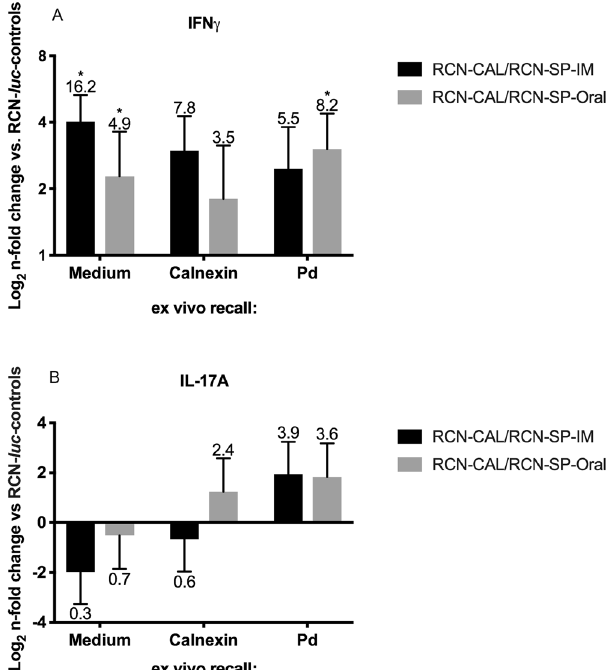
Figure 6. Expression of IFN- γ ( A ) and IL-17A ( B ), measured by RT-PCR, in pooled spleen and axillary lymph nodes of vaccinated Myotis lucifugus after challenge with Pseudogymnoascus destructans (Pd) , and ex vivo recall with calnexin (CAL), Pd or medium (non-stimulated). Bats had been vaccinated with raccoon poxviruses (RCN) expressing CAL and serine protease (RCN-CAL/RCN-SP) via intramuscular (IM; n = 8) or oral (n = 7) administration, or sham vaccinated with RCN expressing luciferase (RCN- luc ; n = 3). Bars and error bars represent average n-fold changes (indicated by the number above the error bar) and standard errors normalized to the RCN- luc group. Values marked with an asterisk are significantly different from the RCN- luc control group at a P <